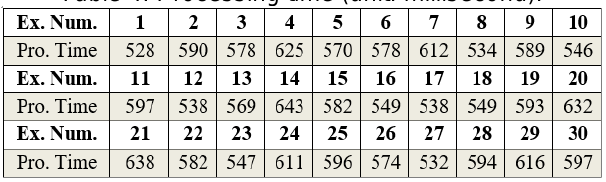
Table 4. Processing time (unit: millisecond).